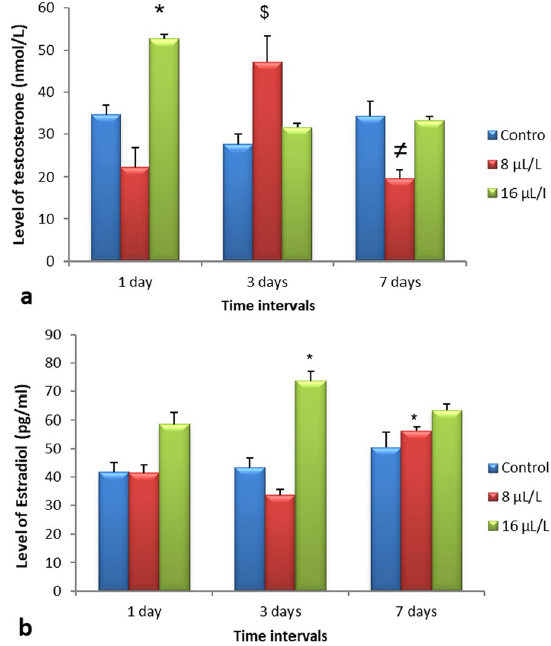
Fig. 2 The effect of different concentrations of RIPEX on steroid hormones in ovotestis of Biomphalaria alexandrina . a Testosterone, b estradiol. Values are expressed as mean SD. Significance difference ± as compared to control (*); ( ≠ ) between the concentrations and ( $ ) between the time intervals when p ≤